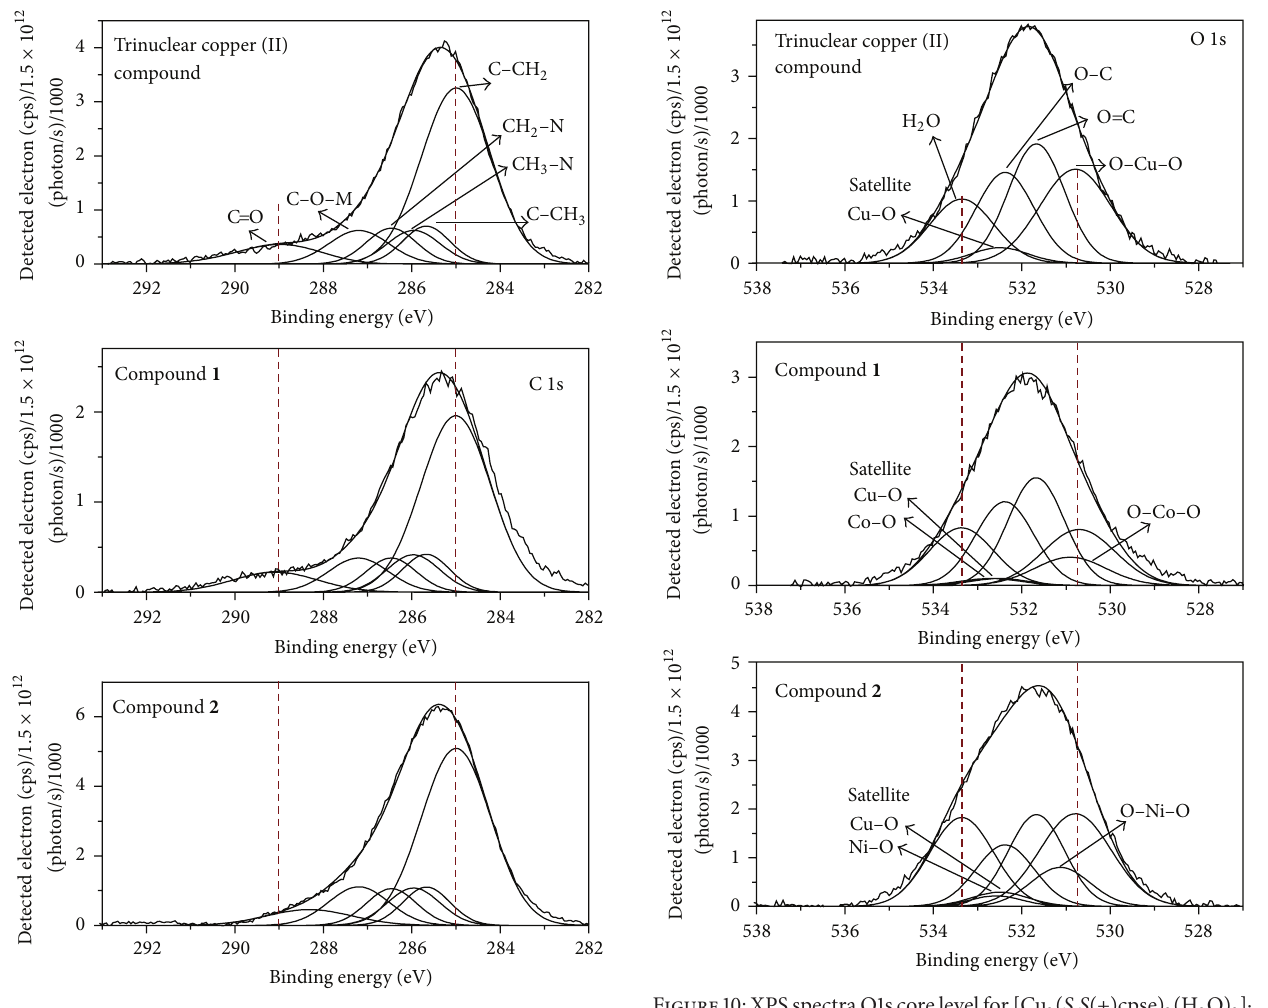
Figure 9: XPS spectra for C 1s core level in [Cu 3 ( S,S (+)cpse) 3 ⋅ (H 2 O) 3 ] ⋅ 8H 2 O for compounds 1 and 2.